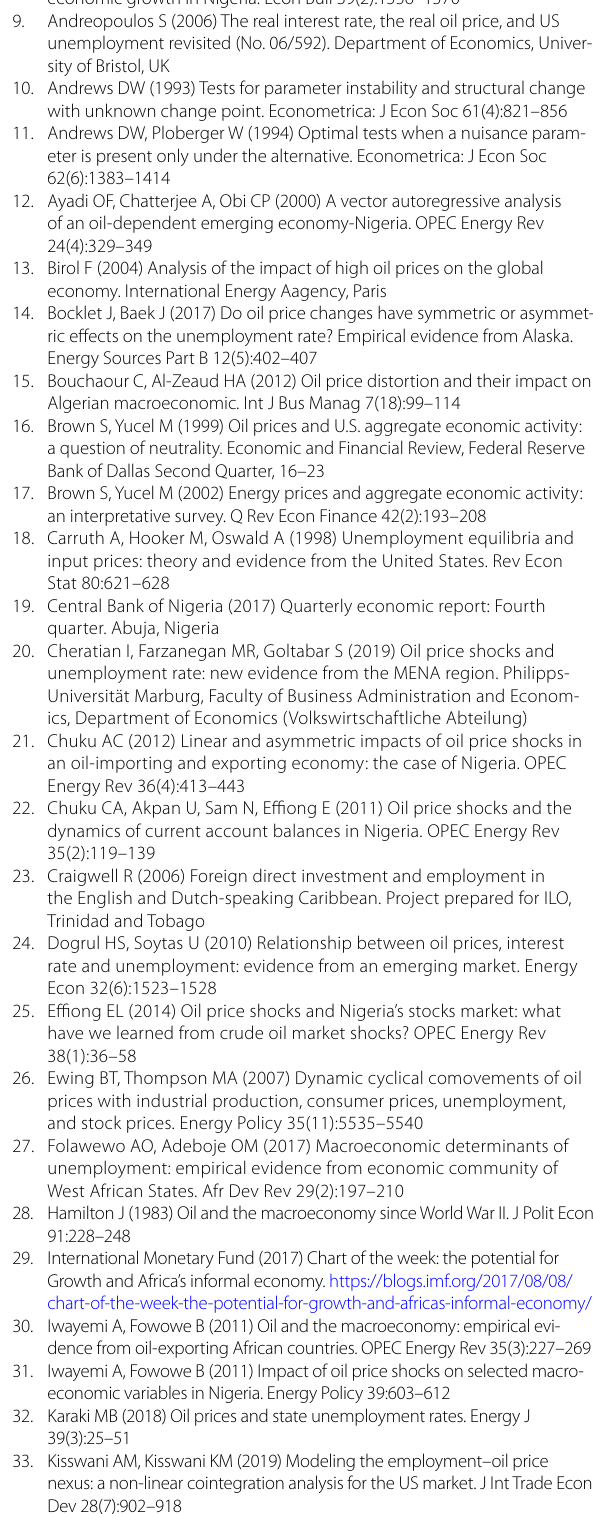
Table 8 Computation of unknown structural break